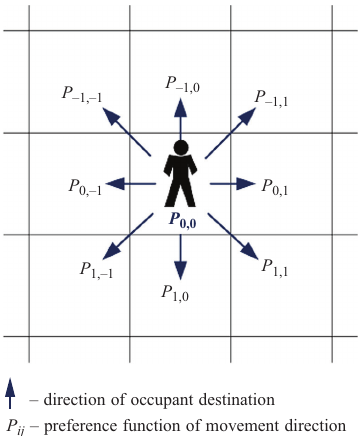
Fig. 4. Preference function of movement direction